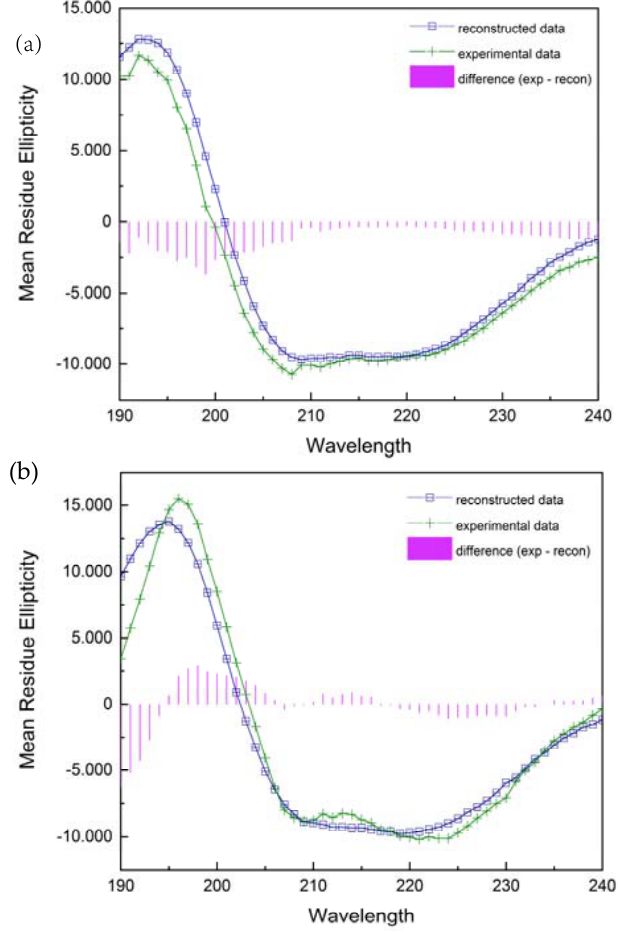
Figure 11. Experimentally collected CD spectra (green) of the 6Ala PNP ( a ) and the WT PNP ( b ) and their reconstruction with the DichroWeb/Selcon 3 program (blue).